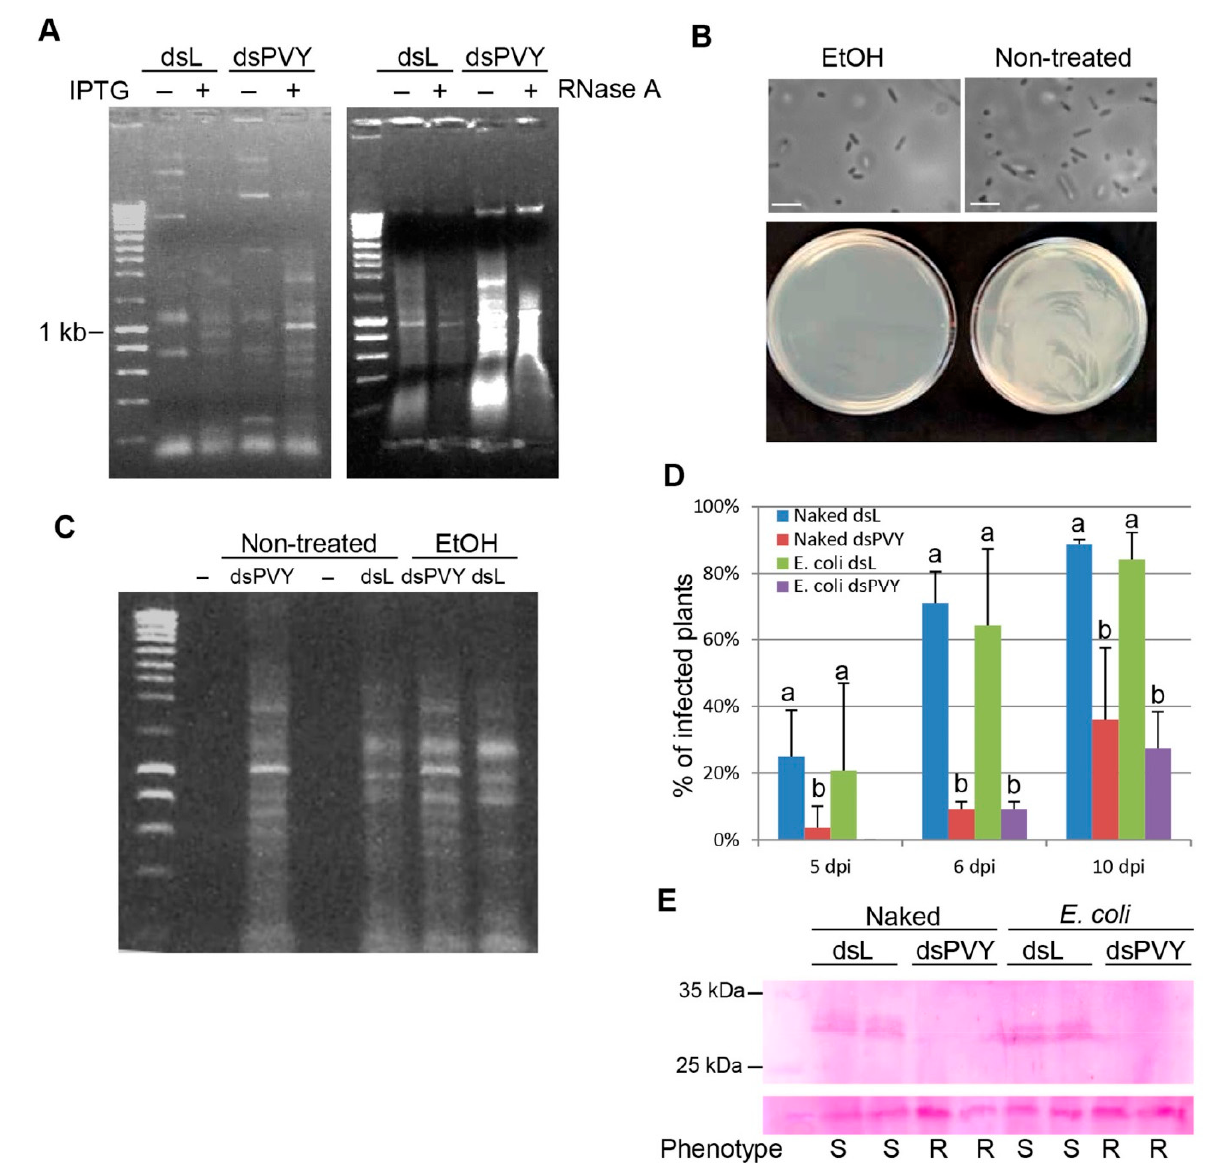
Figure 1. Bacterially produced dsRNA interferes with Potato virus Y (PVY) infection. ( A ) HT115(DE3) cultures transformed with either L4440 expressing a dsRNA consisting of 902 bp of the PVY CP gene (dsPVY) or with the empty plasmid (dsL) were induced with IPTG and processed for total nucleic acid. Samples were resolved by electrophoresis on 1% agarose gel before (left panel) or after treatment with RNase A (right panel). NZYDNA Ladder III was used as DNA markers. ( B ) Bacterial cells were non-treated or treated with ethanol 70% and imaged using a charge coupled device (CCD) camera (160×, upper panel). Scale bar denotes 2 µm. Suspension cells were plated on Luria–Bertani (LB) agar for testing survival (bottom panel). ( C ) Nucleic acids were extracted from treated and non-treated cells expressing dsPVY and dsL and electrophoresed on 1% agarose gel. ( D ) Nicotiana benthamiana plants were inoculated with mixtures of PVY combined with nucleic acid extracts prepared from E. coli accumulating the dsPVY (naked dsPVY) or E. coli -encapsulated dsPVY ( E. coli dsPVY). Total nucleic acid extracted from E. coli expressing the dsL or E. coli -encapsulated dsL were used as controls. The mean percentage ± standard deviations of inoculated plants showing systemic symptoms in three independent experiments was monitored at different days post-inoculation (dpi). Statistical comparisons between means were made by employing Scheffé’s multiple range test ( p < 0.05). Different letters indicate significant differences at p values of 0.05. ( E ) Western blot analysis of protein extracts derived from upper leaves of plants susceptible (S) or resistant (R) at 10 dpi, using antibodies against PVY CP. The lower panel shows the Ponceau S-stained membrane after blotting, as the control of loading.